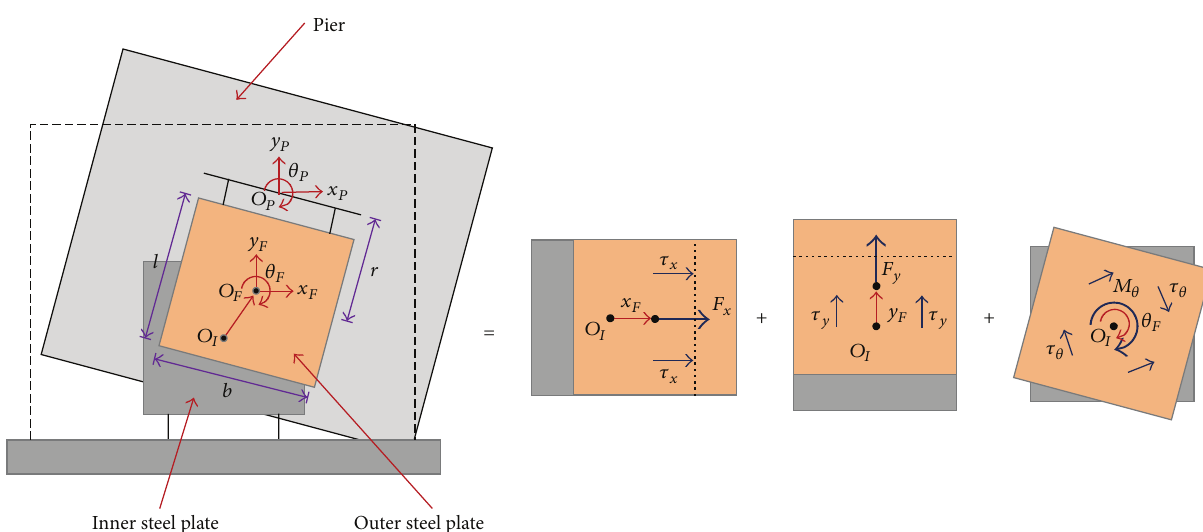
Figure 2: Mechanical model of the viscoelastic